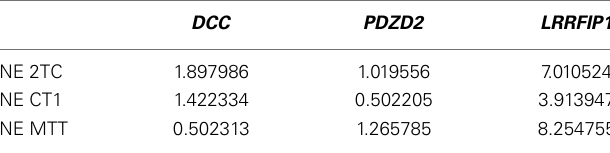
Table 7 | Expression ratio of (short isoform/long isoform) normalized to reference sample, derived from Q-RT-PCR